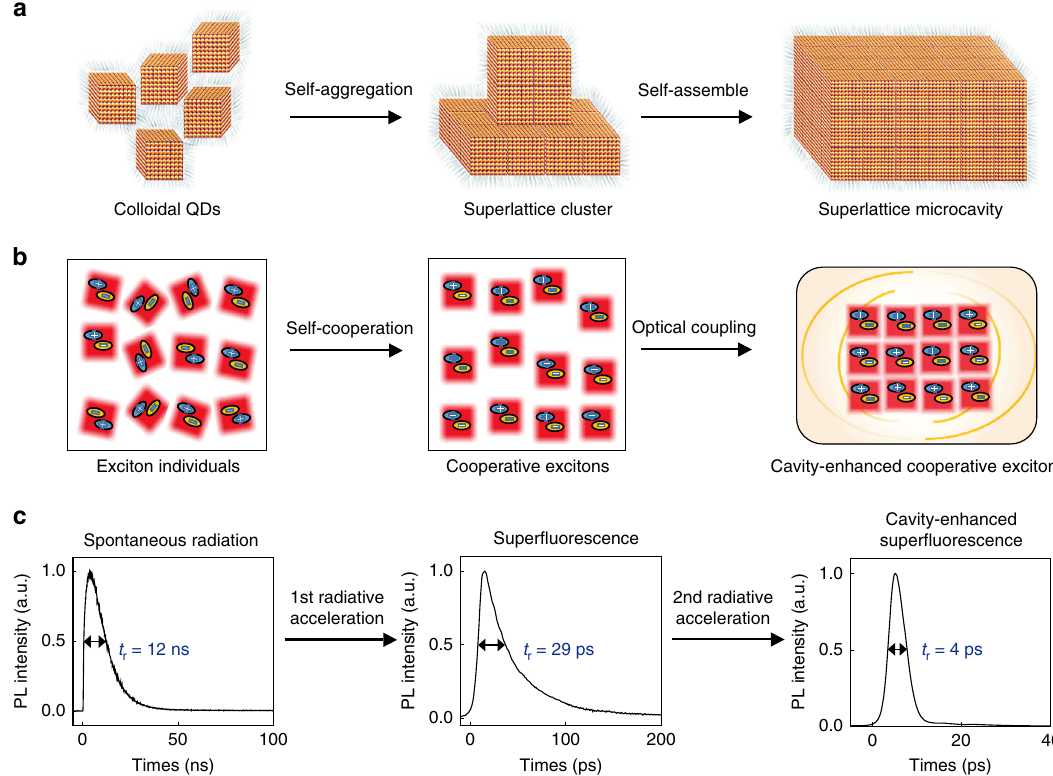
Fig. 1 Linking “ self-assembly of QDs ” to “ phase transitions of exciton ensemble ” , and “ optimization of radiative features ” . a Self-assembly evolution from monodisperse colloidal QDs (left) to a closely packed SC (middle) and fi nally to a highly symmetric QDSM (right). The whiskers around the cubic QD are oleylamine and oleic acid ligands. b Phase transitions of exciton ensemble in the structures discussed above. The “ + ” and “ − ” orientations indicate the phase of dipole moments. c Experimental radiation dynamics. Monodisperse QDs radiate spontaneously with a radiative time t r (the full-width at half- maximum (FWHM) of the dynamical PL peak) of tens of nanoseconds, while self-cooperating excitons in the SC emit a SF pulse with t r on the order of 10 ps. Furthermore, the cavity fi eld in the QDSM accelerates the SF process, with t r reaching as low as a few